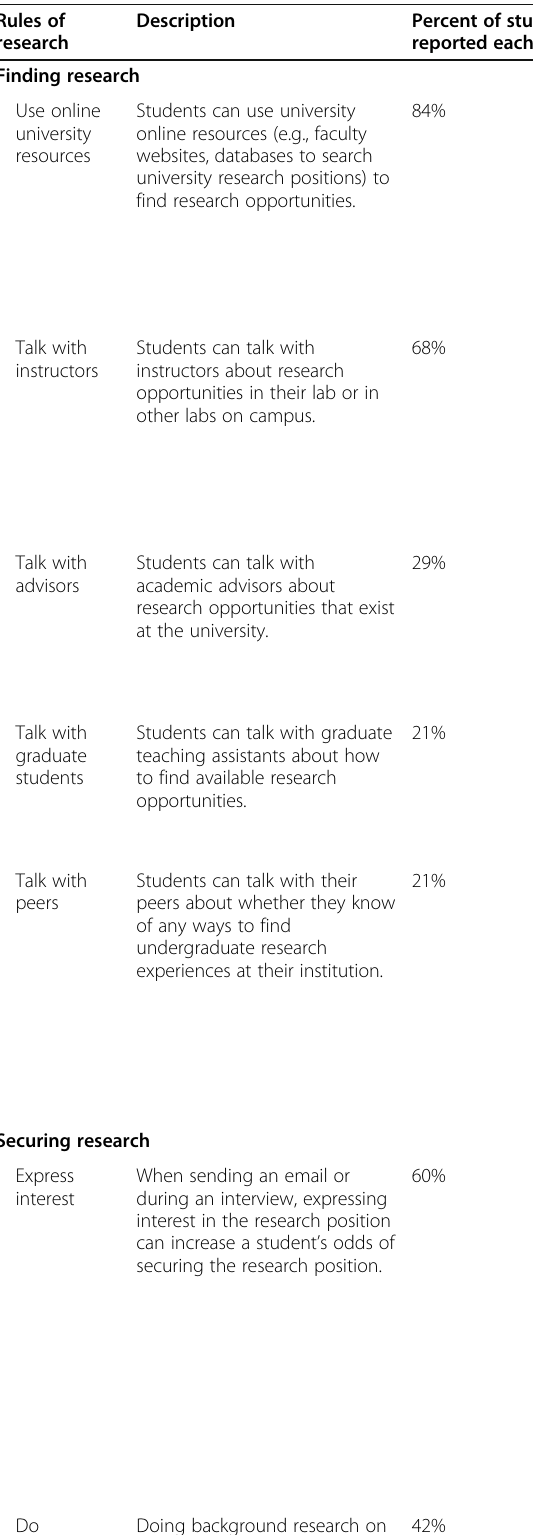
Table 2 Each rule of research described by interviewees about how to find a research experience and how to secure a research